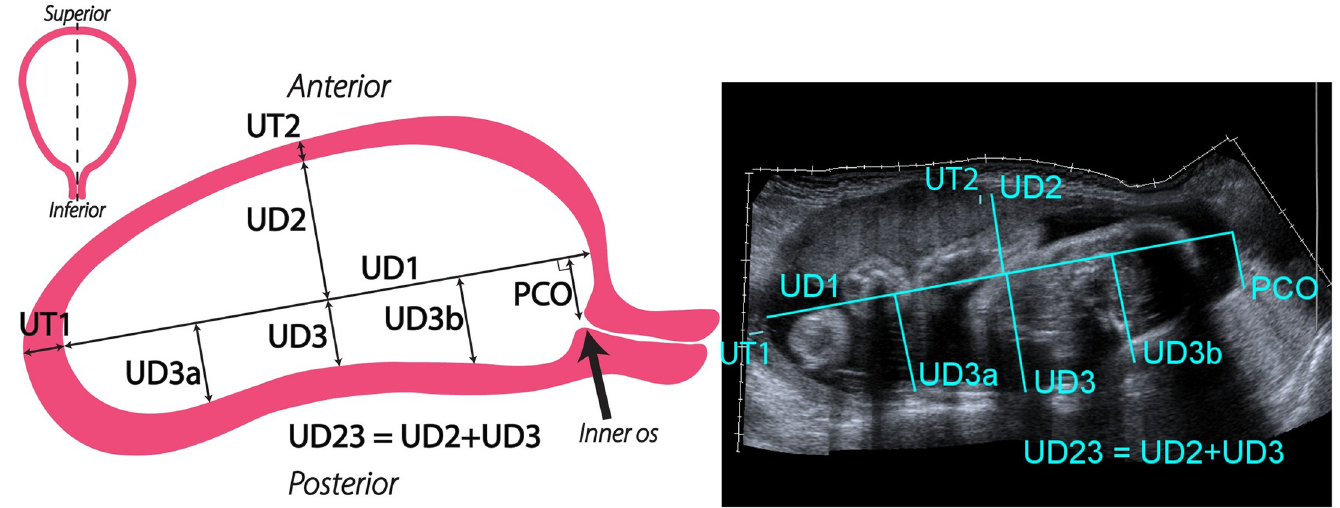
Fig 2. Representative and actual transabdominal (TA) sagittal scan of a pregnant patient at 32 weeks. Left: coronal uterine outline with the ultrasound sweep location shown with a dashed line, and a representative illustration of measurements taken from ultrasounds of the uterus and cervix in the sagittal view. Right: actual transabdominal (TA) sagittal view of the uterus taken as a extended field-of-view ultrasound sweep from uterine fundus to the cervix. Measurements taken from the TA sagittal view are: inferior-superior (UD1) and anterior-posterior intrauterine dimensions (UD2, UD3, UD3a, UD3b), uterine wall thickness measurements (UT1, UT2), and the distance the internal os is offset from the inferior-superior uterine axis (PCO).